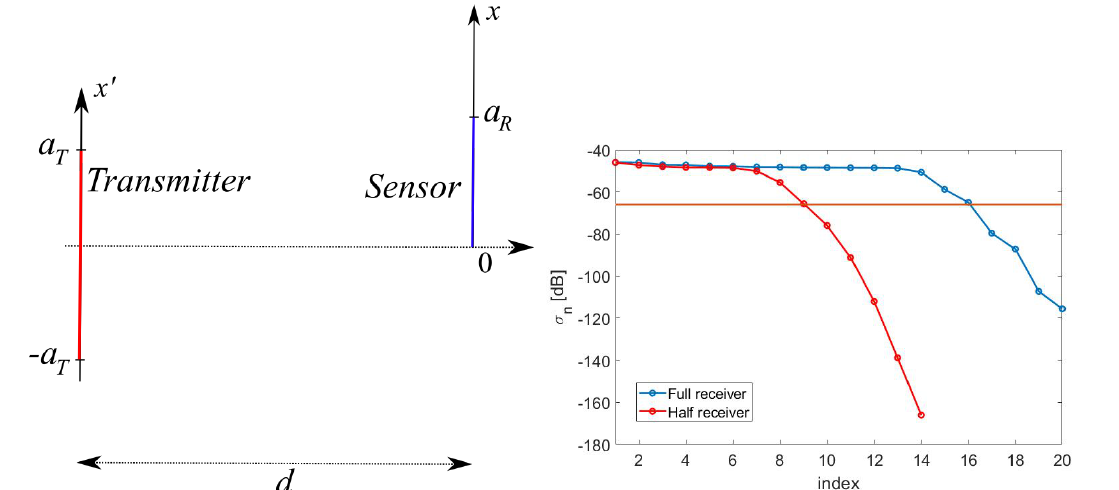
Figure 13. ( Left ): Illustrating the “optimal” reception problem for a halved upper aperture. ( Right ): SVB for the half-sensing aperture case.